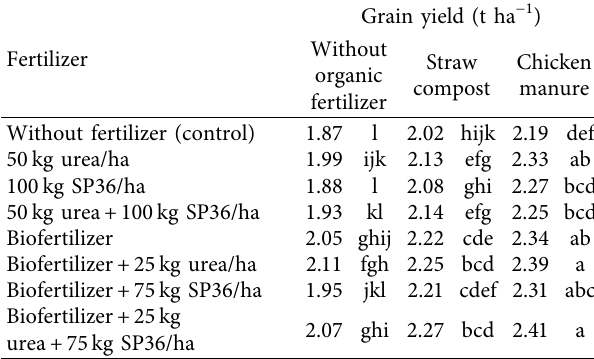
Table 4: Effect of organic fertilizer from the rainy season and inorganic and biofertilizers applied in the second dry season on the grain yield of